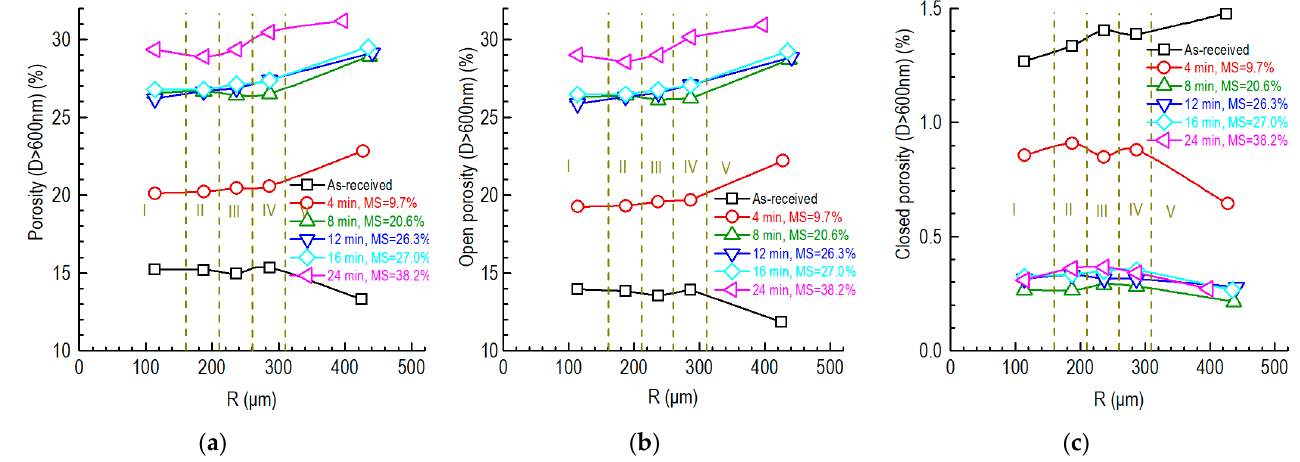
Figure 12. Radial profiles of porosities of partially SiC-coated graphite specimens: ( a ) porosity; ( b ) open porosity; ( c ) closed porosity (MS: mass